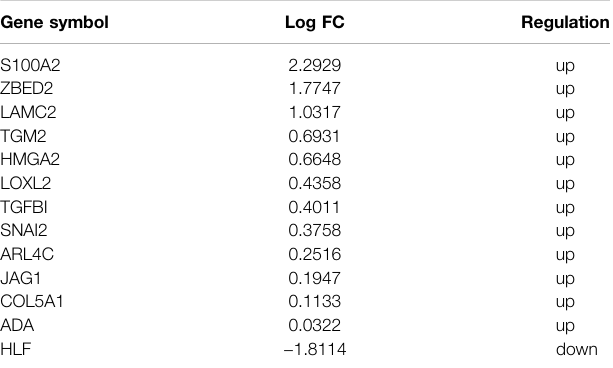
TABLE 1 | Selected 13 EMT genes in